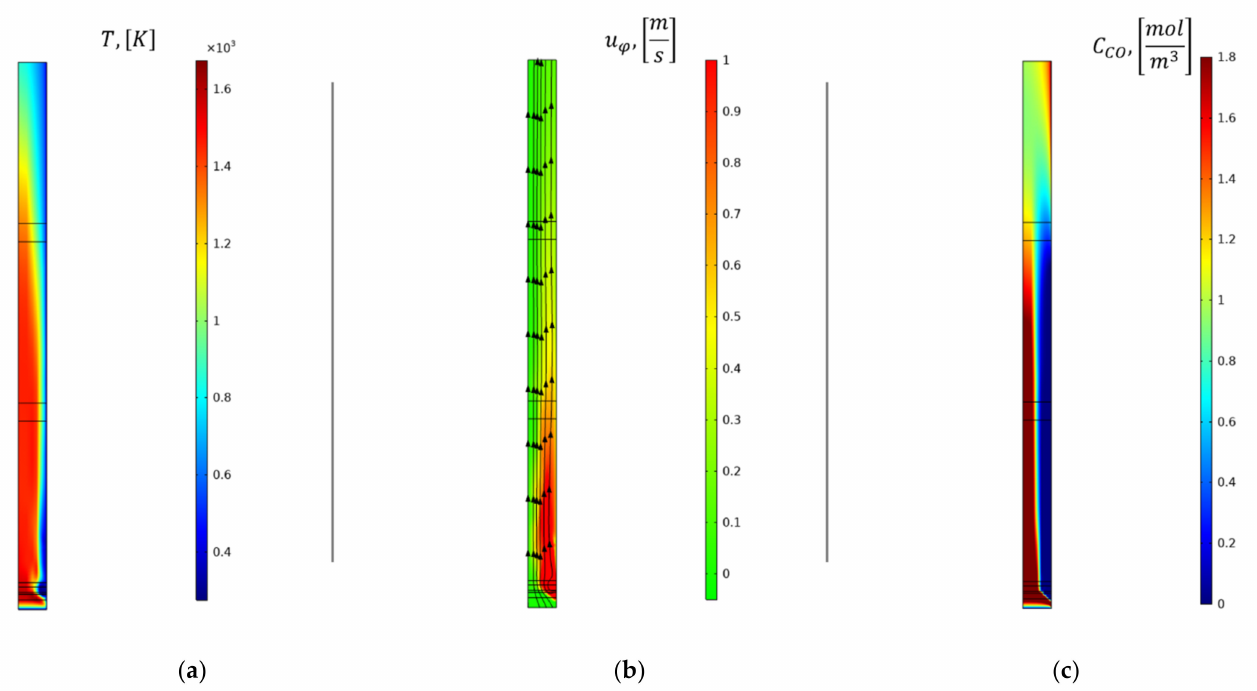
Figure 9. Distributions of fields when using MW pre-treated straw pellets: T MW = 473 K: ( a ) tempera- ture, ( b ) velocity field, ( c ) concentration of